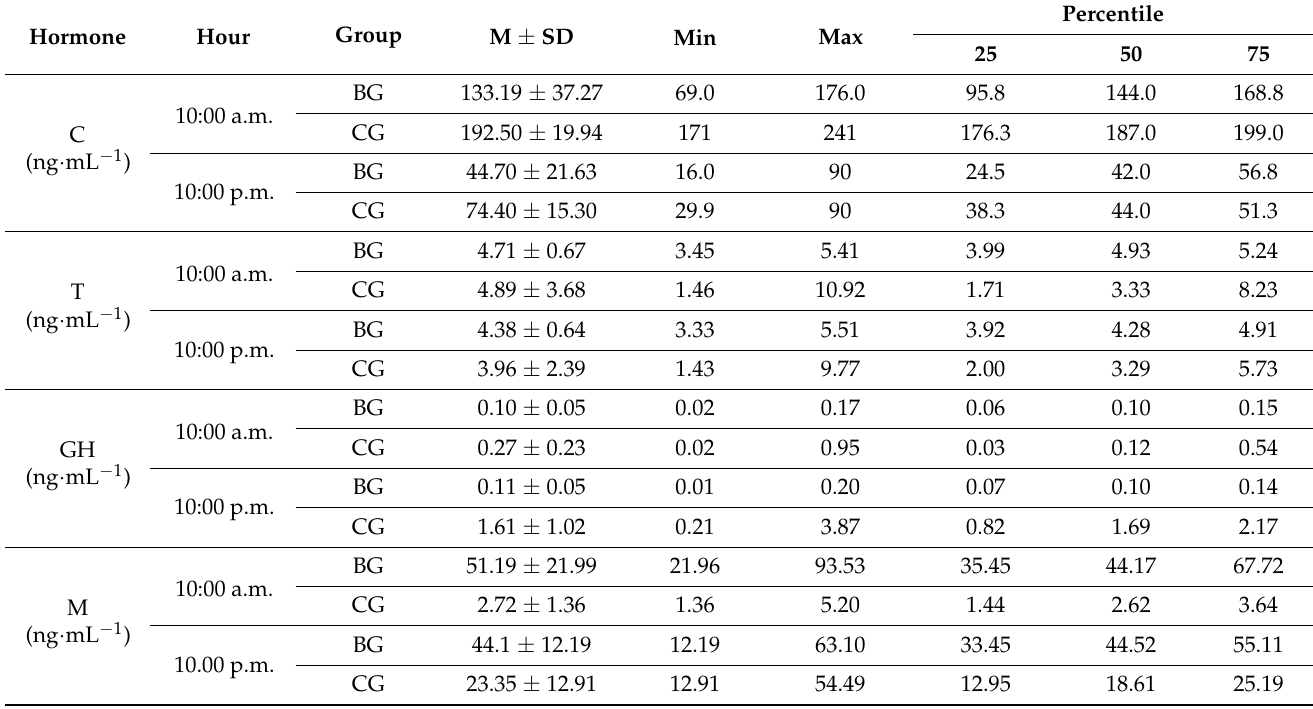
Table 2. Concentrations of cortisol, testosterone, growth hormone, and melatonin collected before the exercise in blind men and in the control